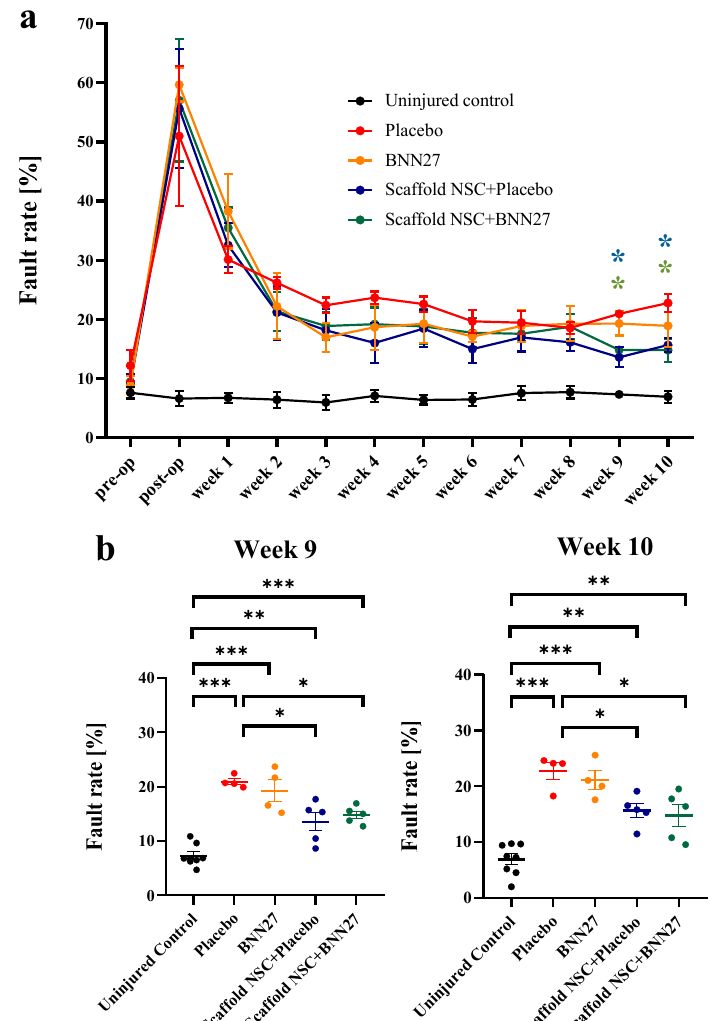
Figure 1. Effects of NSC-seeded PCS grafts and systemic administration of BNN27 on locomotion recovery. ( a ) Quantification of locomotion performance (fault rate) after SCI by the horizontal ladder walking assay over a period of 10 wpi (“Uninjured Control” group: n = 8, “Placebo” and “BNN27” groups: n = 4, “Scaffold NSC” and “Scaffold NSC + BNN27” groups: n = 5). The complete dataset is available in Supplementary Materials: Figure S2. Asterisks indicate the statistically significant difference between the “Placebo” group and the “Scaffold NSC + Placebo” group (blue) or the “Scaffold NSC + BNN27” group (green) at 9 and 10 wpi. ( b ) Dot plot of locomotion fault rate at 9 and 10 wpi. Results are presented as mean ± SEM. * p < 0.05, ** p < 0.01, *** p < 0.001; Tukey’s post hoc pairwise test assuming P 1-way-ANOVA < 0.05.